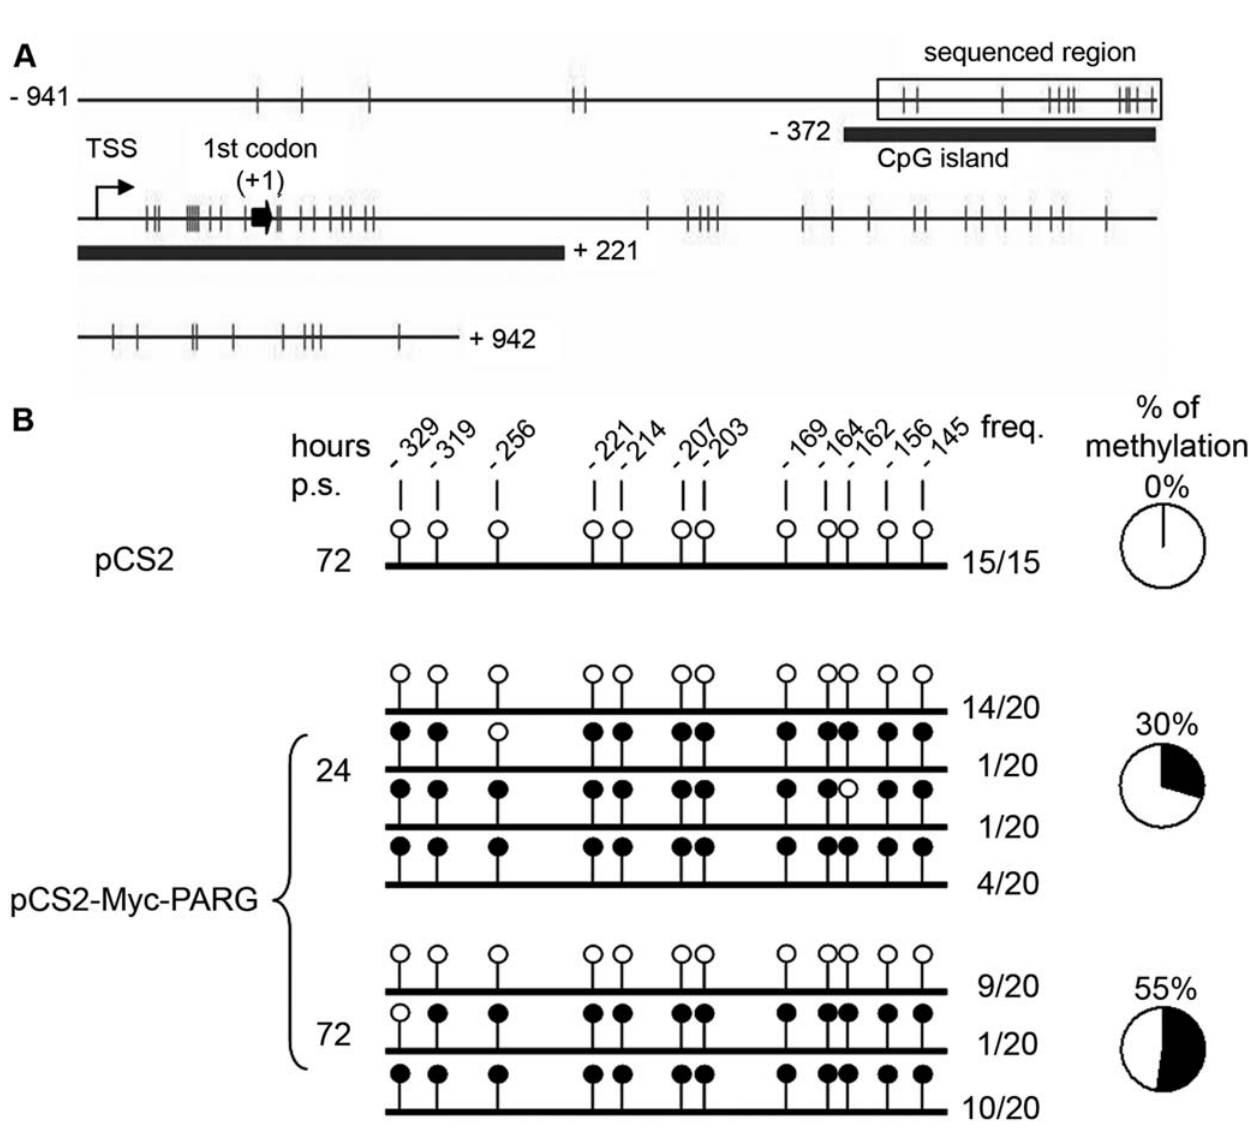
Figure 3. Ectopic over-expression of PARG changes the methylation pattern of the CGI located in 5 9 regulatory region of the Dnmt1 gene. A, Graphical representation of the CGI region (gray line) in the promoter region of Dnmt1 . Numbers indicate the distance in base pairs from the first codon (black arrow); TSS: transcription start site; dashes: GpG dinucleotides. B, The methylation state of Dnmt1 promoter region spanning base pairs 2 364 to 2 103 was evaluated by bisulphite sequencing following transfection with either pCS2 or pCS2-Myc-PARG vectors at 24 and 72 hours of puromycin selection. Up to twenty independent clones for each sample were analysed by the sequencing procedure. Each row of circles represents the sequence of an individual clone. Open circle, unmethylated CpG site; filled circle, methylated site. Frequency: number of clones with depicted methylation pattern of all clones tested under the specified conditions.